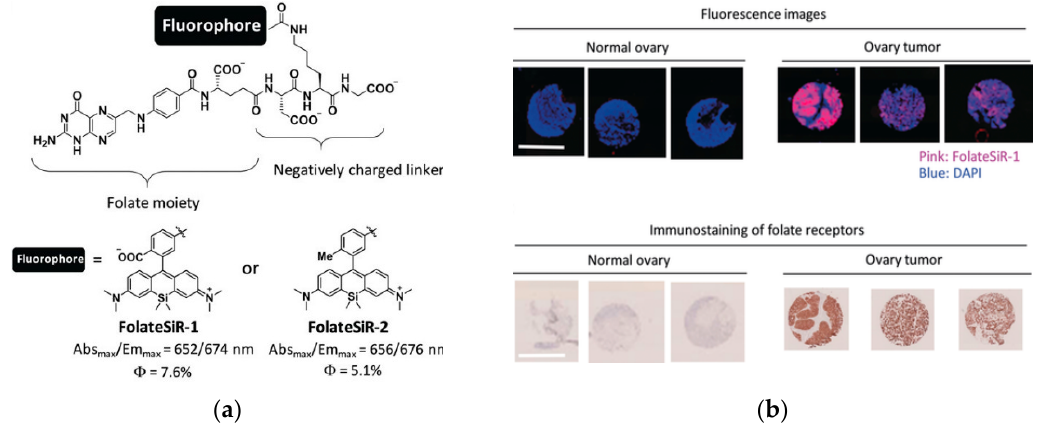
Figure 14. Immunostaining of folate-receptor expressing tumors: ( a ) Molecular design of fluorescent probes for detection of folate receptors and the structures of FolateSiR-1 and FolateSiR-2 ; ( b ) Ovarian cancer tissue microarray with FolateSiR-1 and DAPI (nuclear stain). Adapted with permission from [209]. Scale bars = 2 mm.